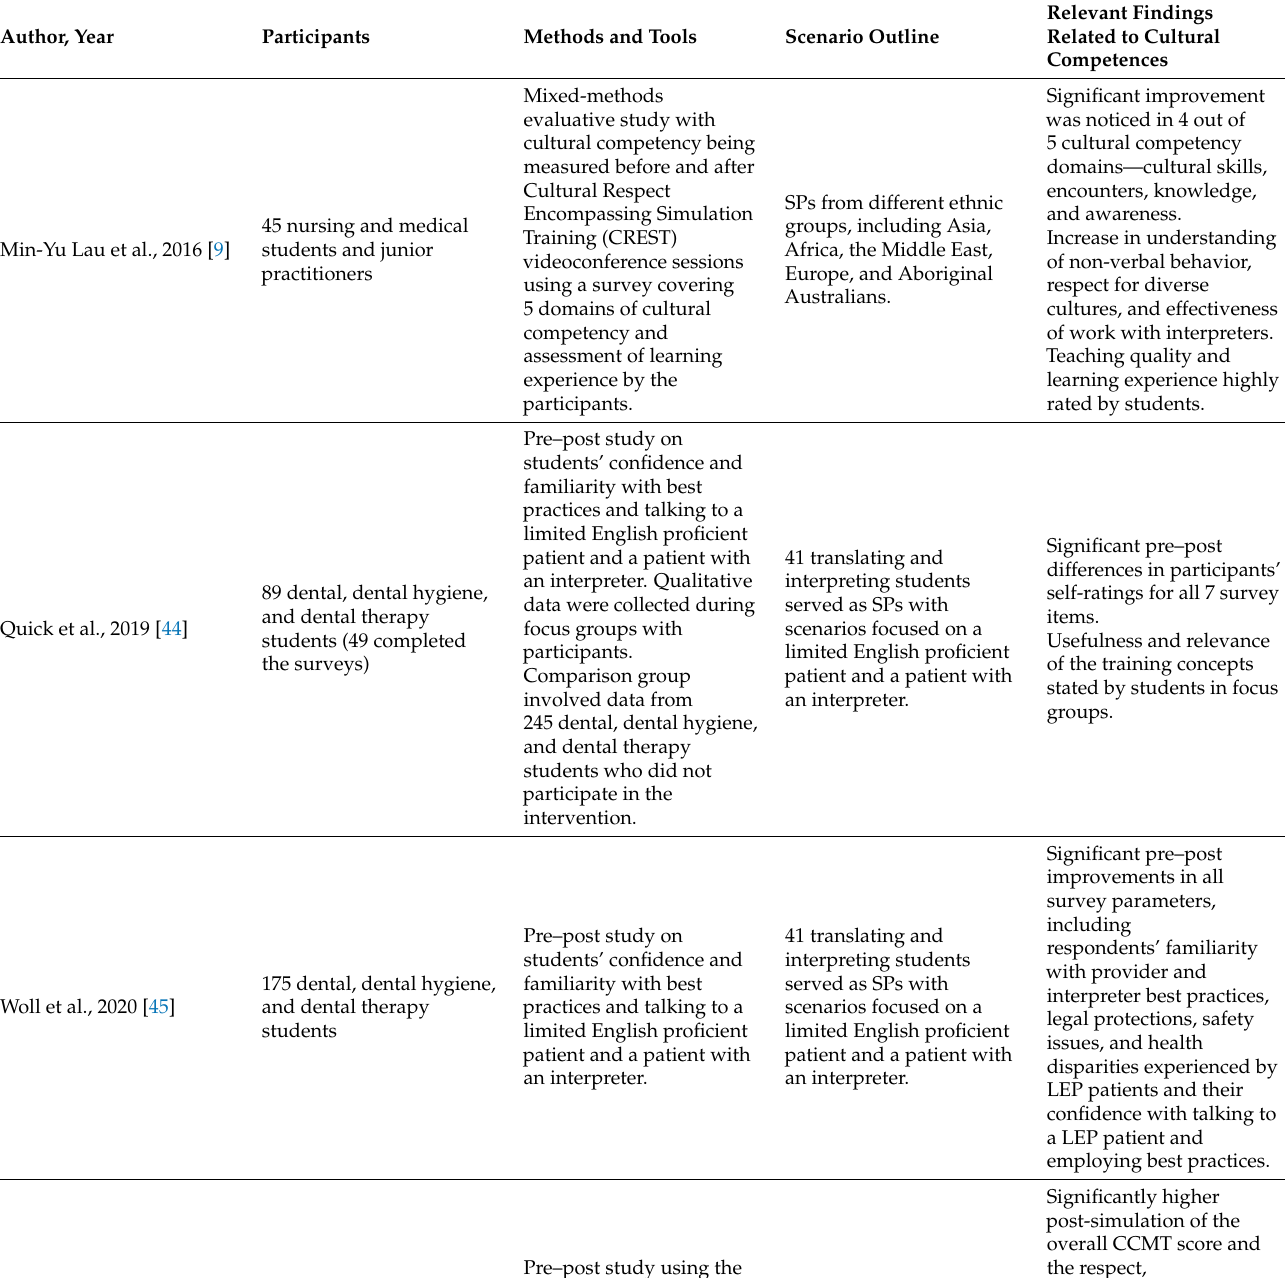
Table 5. Descriptive summary of studies on interprofessional groups of